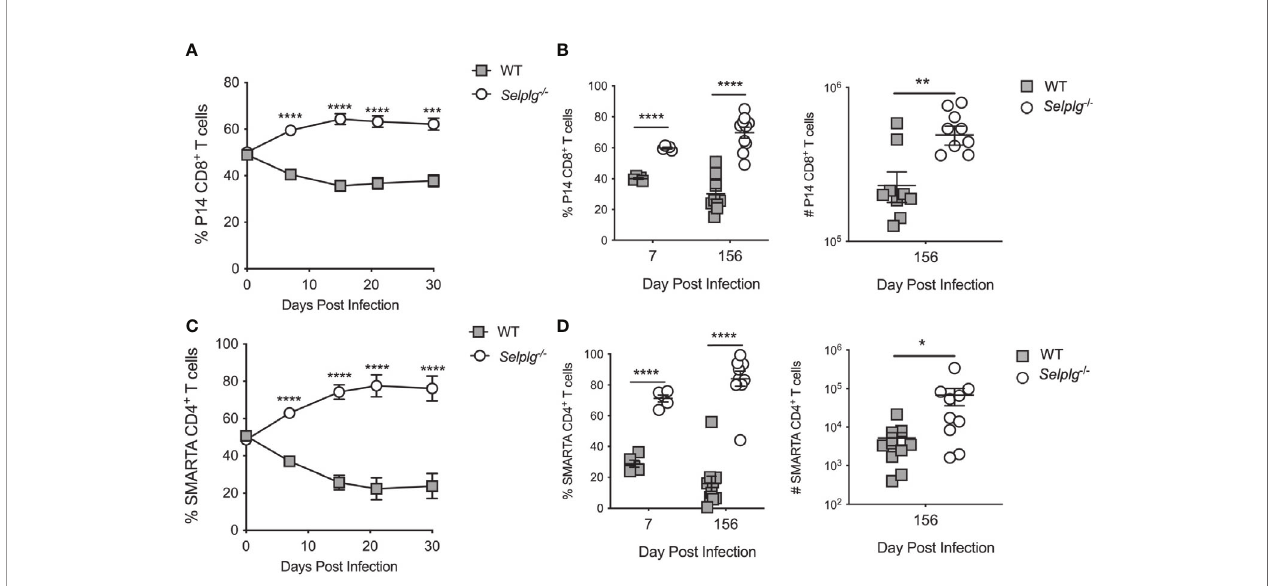
FIGURE 6 | Selplg -/- T cells display increased cell-intrinsic accumulation as effector and memory T cells. (A) Frequencies of WT and Selplg -/- P14 T cells in the blood after adoptive transfer into naïve WT recipients and infection with LCMV Arm. (B) Frequencies and numbers of P14 T cells in the spleens at 7- and 156dpi. (C) Frequencies of WT and Selplg -/- SMARTA T cells in the blood after adoptive transfer and infection with LCMV Arm. (D) Frequencies and numbers of SMARTA T cells in the spleens at 7- and 156dpi. Data are representative of three independent experiments (n = 5 or more mice/group). Graphs show the mean ± SEM * p < 0.05, ** p < 0.005, *** p < 0.001, **** p < 0.0001 by two-tailed unpaired t-